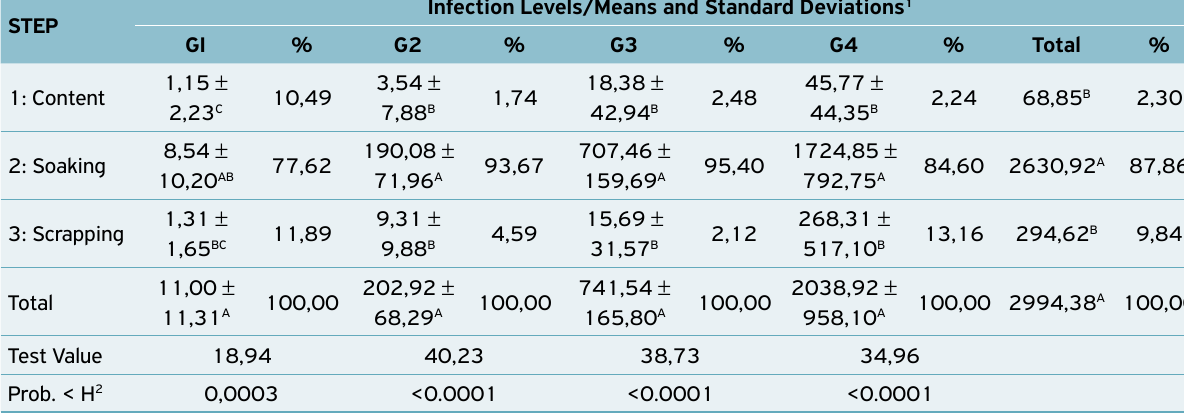
Table 1. Results of multiple comparisons of scolices recovered during bird necropsy.